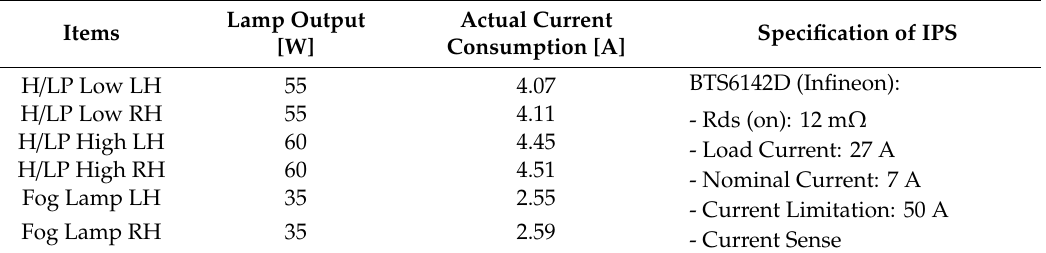
Table 2. Specifications of the output in terms of the load, current consumed, and